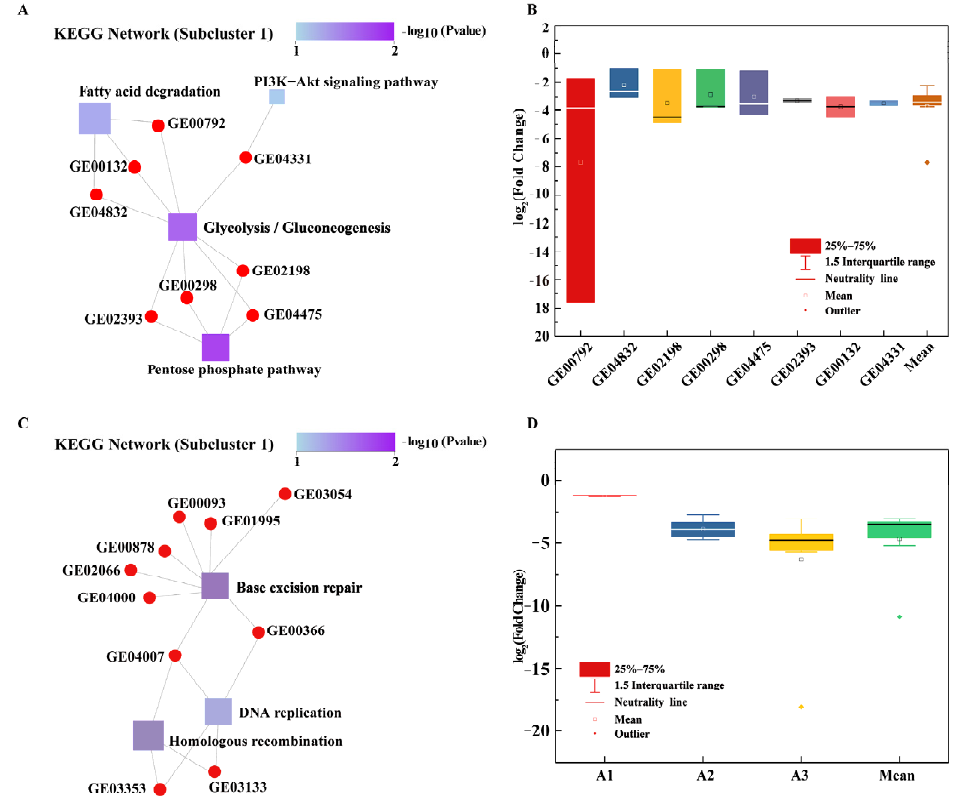
Figure 4. Gene functions and expression levels in strain R-001 exposed to different concentrations of BPA. ( A ) The significantly enriched function-gene interaction network for the glycolytic/gluconeogenic pathway. Square nodes represent functional information, circular nodes represent genes, and lines represent the associations between genes and functions. The color of the square node corresponds to p value, with increasing color intensity reflecting an increasing degree of enrichment. The size of the square node corresponds to the number of associated interactions: larger squares interact with more DEGs and thus likely have a greater influence on biological phenomena. ( B ) The expression levels of genes associated with glycolysis/gluconeogenesis. ( C ) The significantly enriched function-gene interaction network for base mismatch repair. ( D ) The expression levels of genes related to the glyoxylate and dicarboxylate metabolism pathway in different BPA treatment groups.